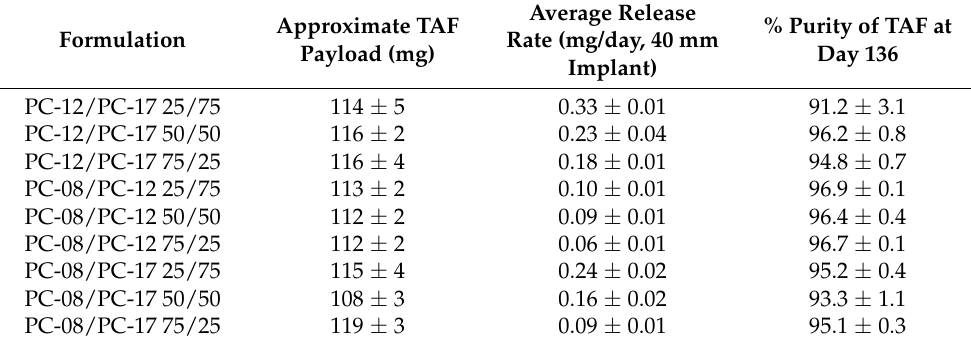
Figure 4. Cumulative release profiles of TAF from implants fabricated with PCL MW blends comprising (a) PC ‐ 08/PC ‐ 12 binary blends, (b) PC ‐ 08/PC17 binary blends, and (c) PC ‐ 12/PC ‐ 17 binary blends. All implants were formulated with a 2:1 mass ratio of TAF to sesame oil, a wall thickness of 100 μ m, a length of 40 mm, and OD of 2.5 mm. Implants were gamma-irradiated before initiating the in vitro study. All samples were performed in triplicate. Table 3. The average release rates of TAF from implants fabricated with PCL MW blends. The percent purity of TAF was determined at the conclusion of the in vitro studies (i.e., day 136). The approximate quantity of drug payload for implants comprising each PCL formulation. Implants were gamma ‐ irradiated before initiating the in vitro study. All samples were performed in triplicate.